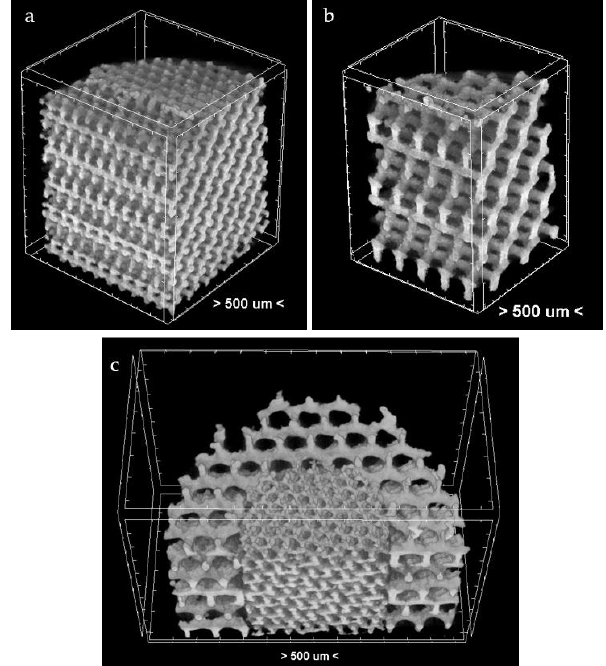
Figure 12. The µ-CT reconstruction of a quarter of 200 µm ( a ); 500 µm ( b ); and a half of 200 + 500 µm ( c ) HF/HNO 3 polished scaffold.